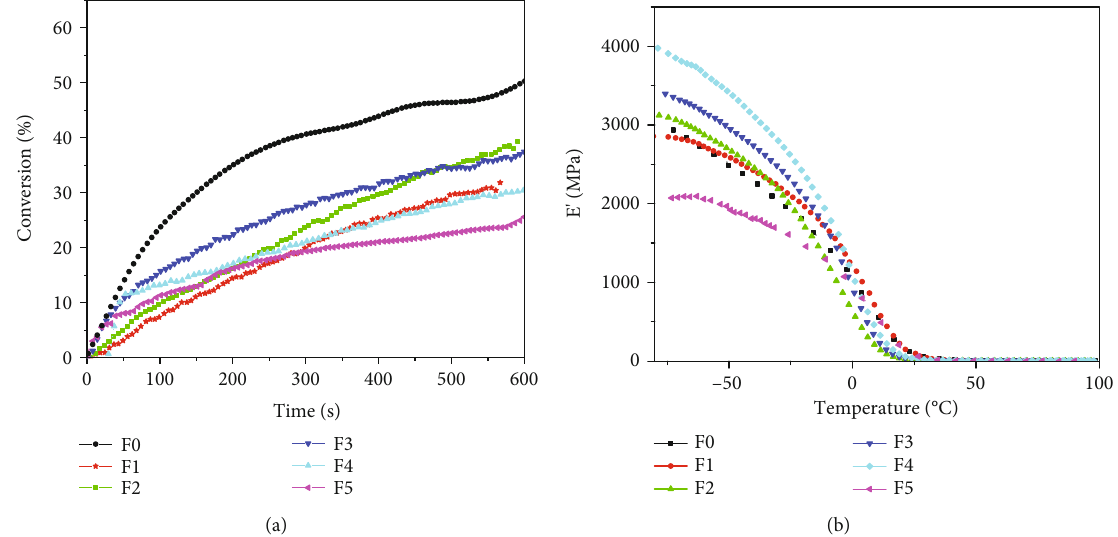
Figure 3: Conversion curves (a) and tensile module (b) of 60wt%. prepolymer C1 formulations with di ff erent TMPO/DOX